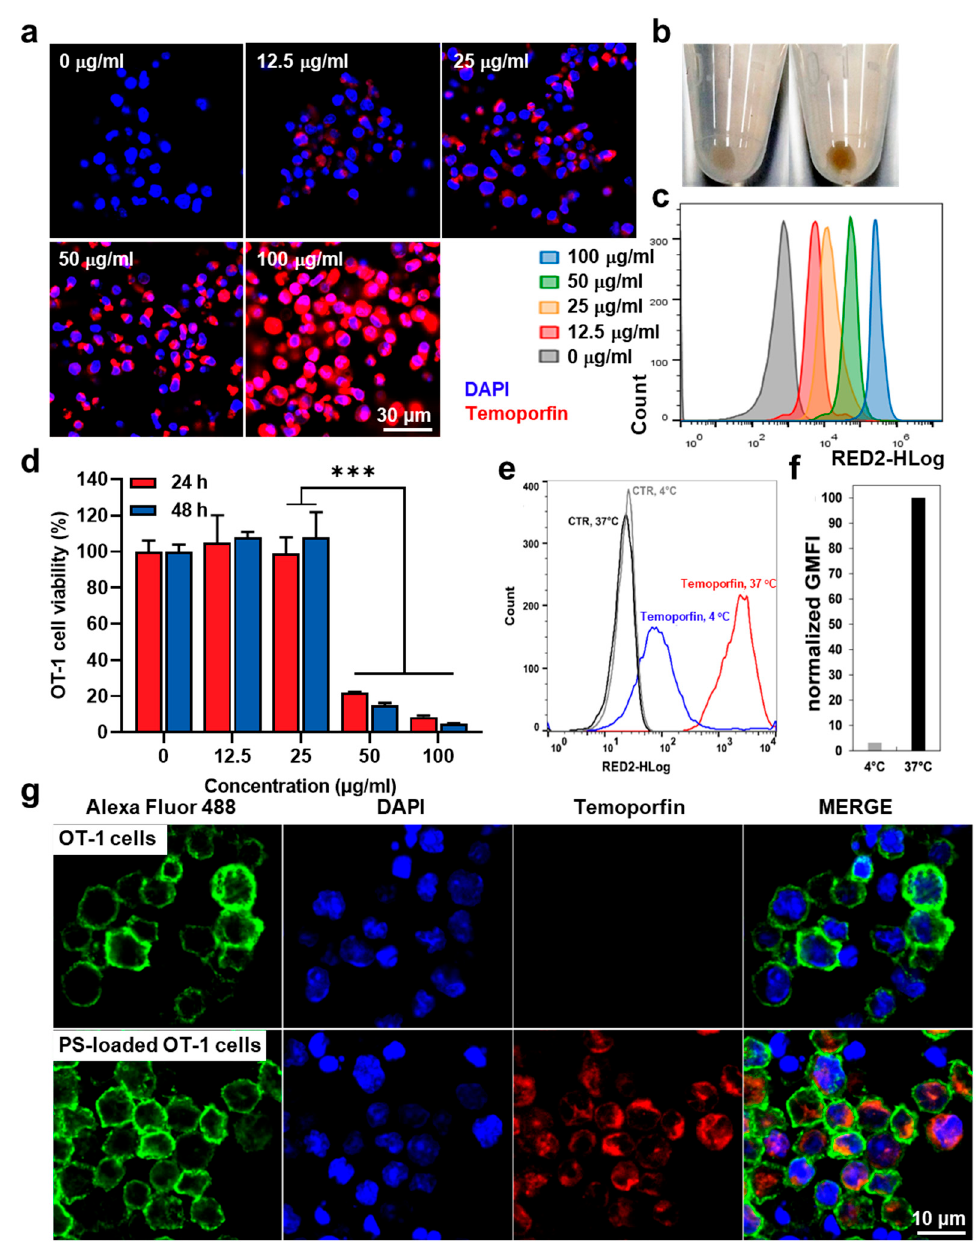
Figure 2. Preparation of temopor fi n-loaded OT-1 cells (PS-OT-1 cells). ( a ) Fluorescence images of OT-1 cells after incubation with di ff erent concentrations of temopor fi n from 12.5 – 100 µg/mL. ( b ) Cell sediment of PS-OT-1 cells or unloaded OT-1 cells that are incubated with 25 µg/mL for 2 h or unloaded OT-1 cells. ( c ) Flow cytometric analysis of OT-1 cells after incubation with di ff erent concentrations of temopor fi n. ( d ) Cell viability of OT-1 cells after incubation with temopor fi n. ( e ) Flow cytometric analysis of OT-1 cells after incubation with temopor fi n at 4 or 37 °C. ( f ) GMFI of OT-1 cells after incubation with temopor fi n at 4 or 37 °C. ( g ) Fluorescence images of PS-OT-1 cells or unloaded OT-1 cells. The asterisk in fi gures indicate a statistical signi fi cance with p value of < 0.001 ***.